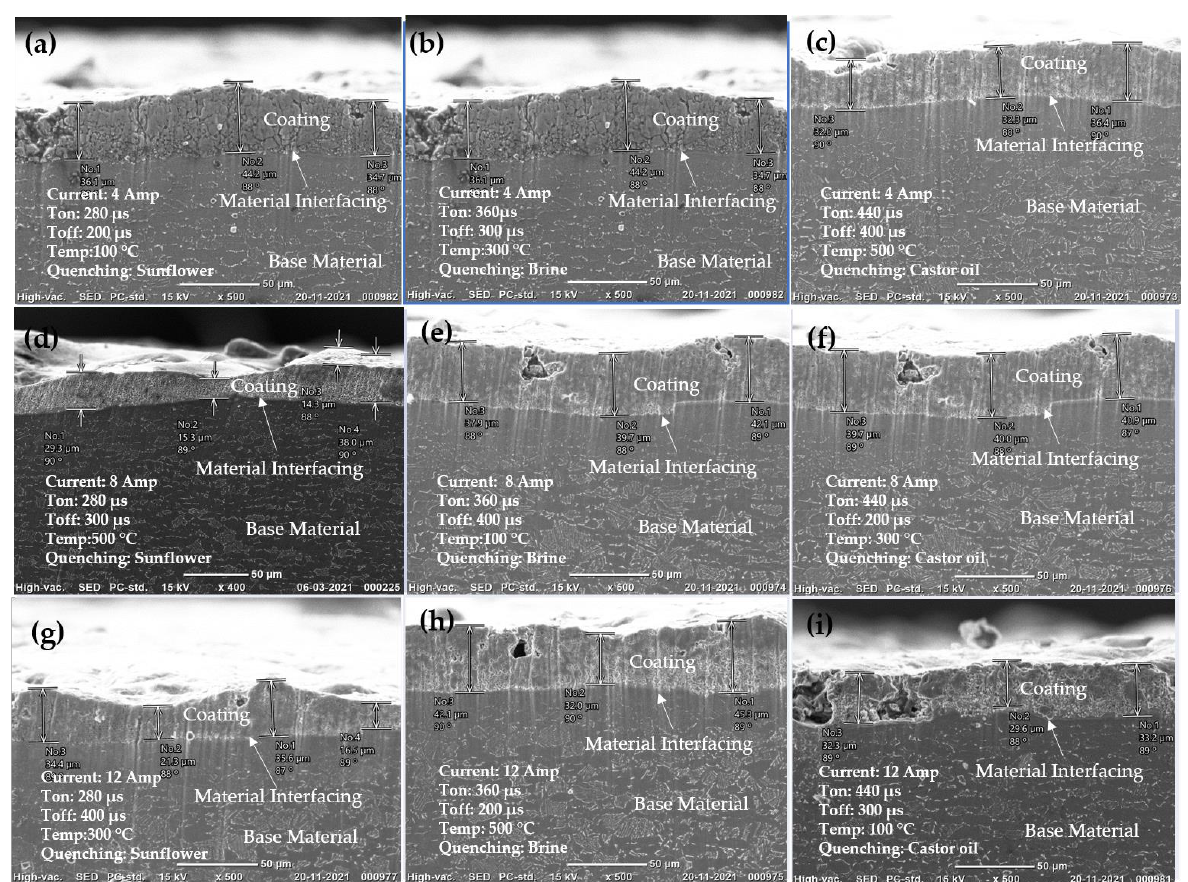
Figure 7. EDC interaction between the base material and coating: ( a ) EX 1, ( b ) EX 2, ( c ) EXP 3, ( d ) EX 4, ( e ) EX 5 and ( f ) EX 6, ( g ) EX 7, ( h ) EX 8 and ( i ) EX 9 (all SEM images are 500X)